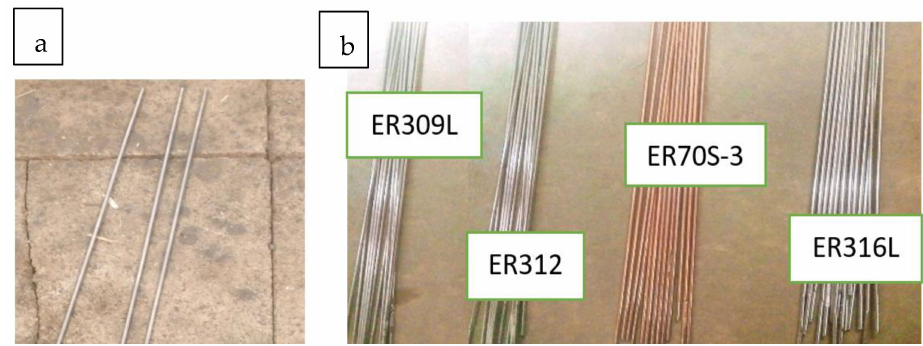
Figure 2. Material used: ( a ) tungsten (98%) with (2%) thorium oxide electrode; ( b ) filler